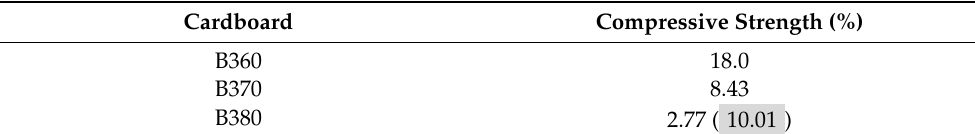
Table 6. Percentage differences between compressive strength of boxes with analog and digital crease lines.